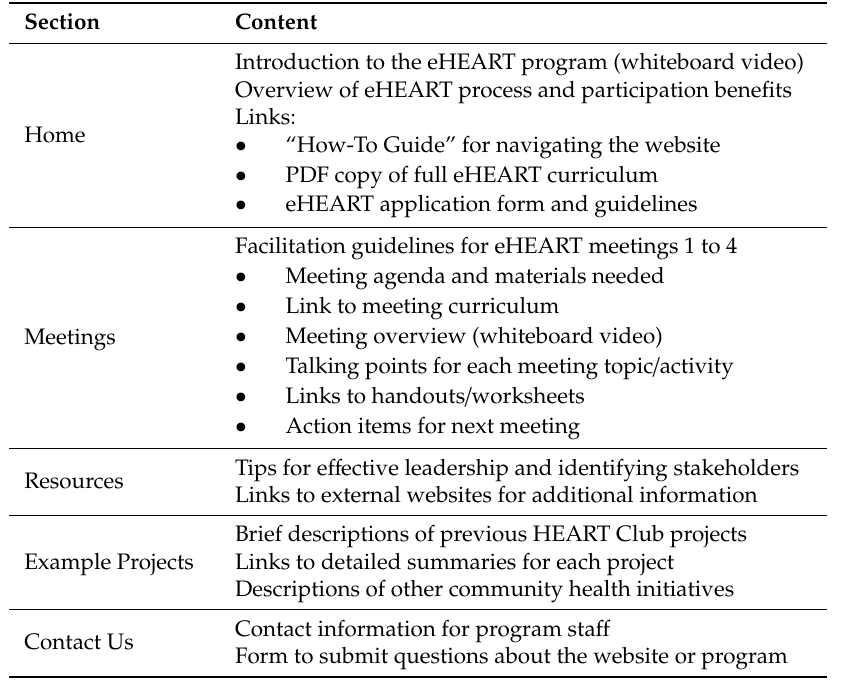
Table 2. eHEART website